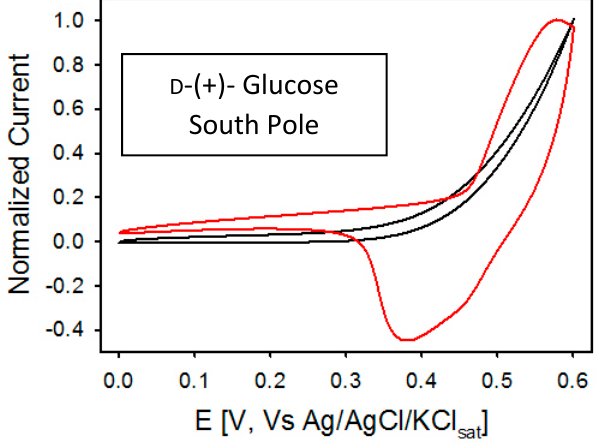
Figure 5. Normalized cyclic voltammetry curves recorded with electrodeposited Ni on the south pole of the magnet. Red curve: KOH 0.1 M aqueous solution. Black curve: 0.1 M of d -( + )-Glucose in KOH 0.1 M aqueous solution. 50 mV / s potential scan rate, Pt as CE, Ag / AgCl / KCl as reference electrodes (RE).